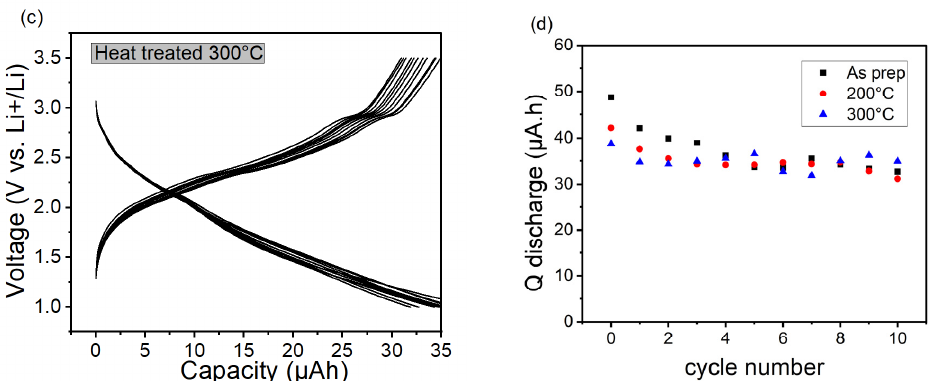
Figure 8. The Charge and Discharge Voltage Profiles ( a ) as-prepared, ( b ) heat treated at 200 °C, ( c ) heat treated at 300 °C, ( d ) discharge capacity vs. cycle number after 10 cycles at 0.5 C rate; the arrow in the figures shows the change from 1st cycle until the 10 th moving from right to left.